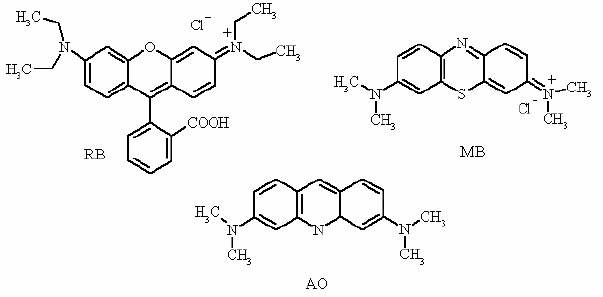
Scheme 1 . Structure of Rhodamine B (RB), Methylene blue (MB) and Acridine orange